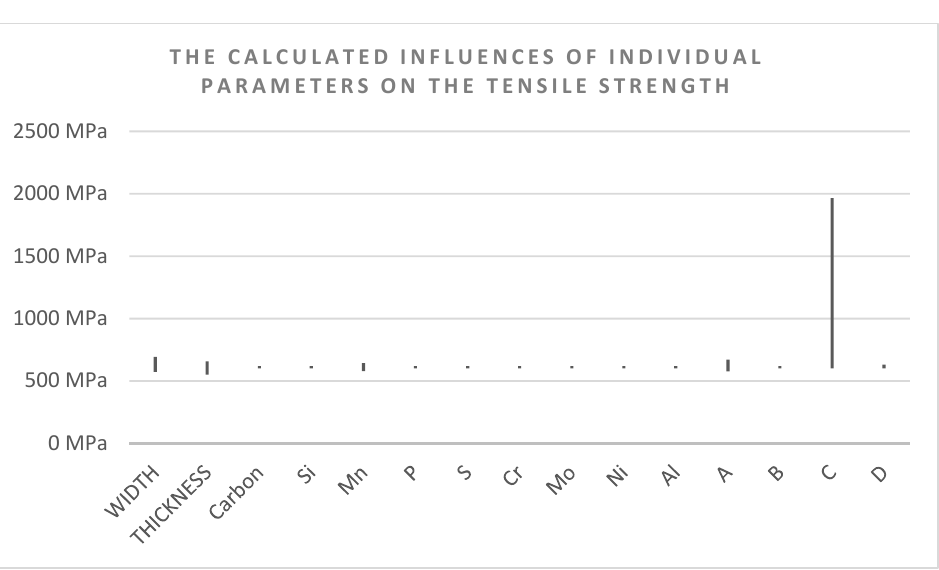
Figure 7. The calculated influences of individual parameters on the tensile strength while separately changing individual parameter within the individual parameter range.